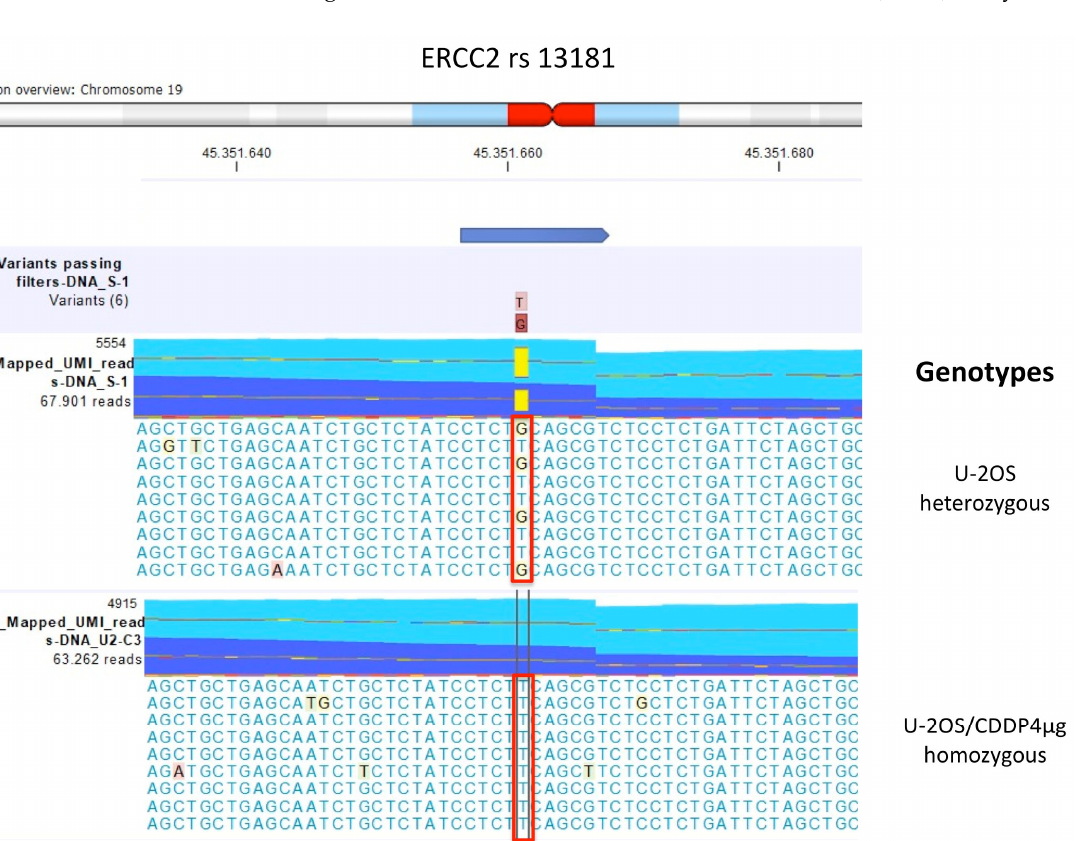
Figure 1. ERCC2 rs13181 genotypes identified by multimodal targeted next generation sequencing (mmNGS) in U-2OS cell line and U-2OS/CDDP4 µ g variant. Mismatched nucleotides were evidenced by the CLC Genomics Workbench (GWB) with a background color according to the Rasmol color scheme. The red square box indicates the polymorphism alleles.